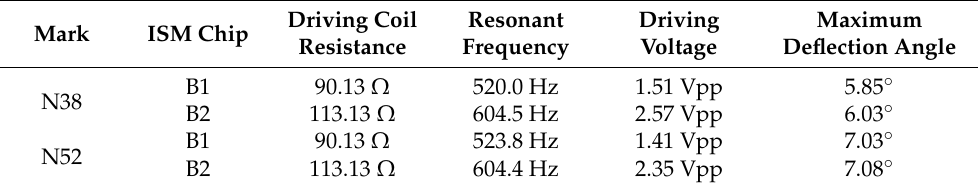
Table 4. Comparative test results of electromagnetic ISM with folded torsion